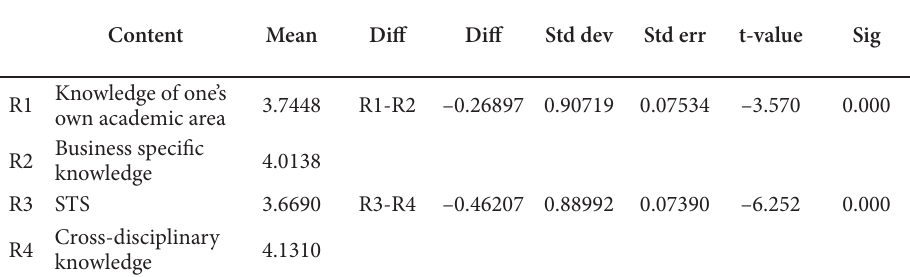
Table 8. Differences in means for general knowledge areas for